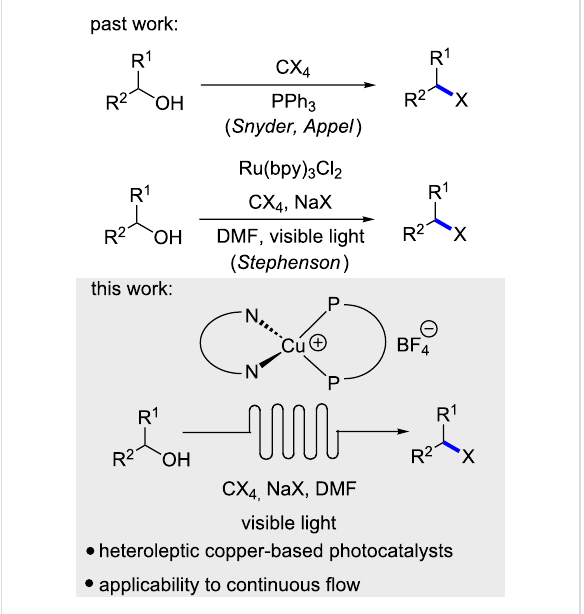
Figure 1: Alcohol → bromide functional group